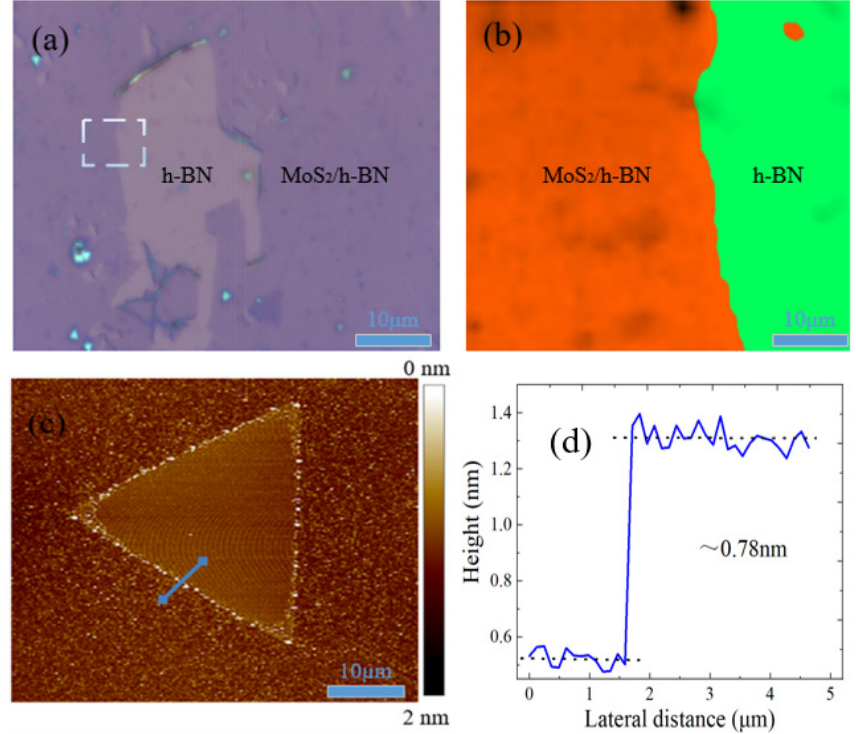
Figure 3. ( a ) Optical micrograph, ( b ) Raman spectrum mapping, ( c ) AFM and ( d ) height profile of MoS 2 /h-BN heterostructure on SiO 2 /Si